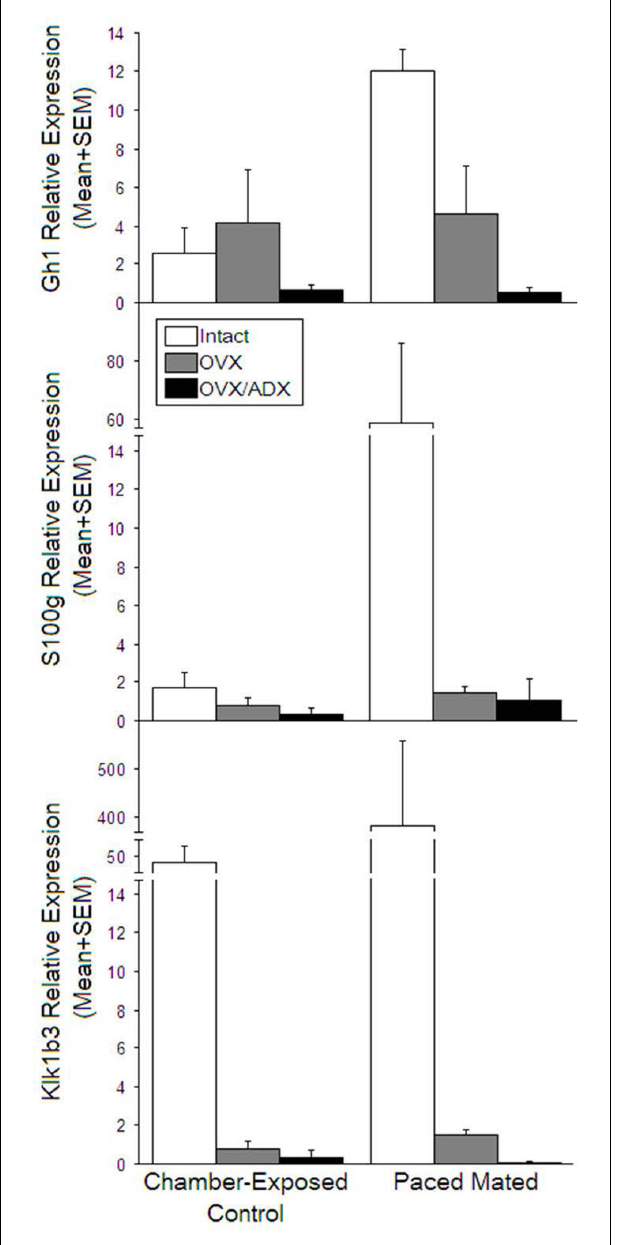
FIGURE 2 | Relative expression among among naturally receptive rats (open bars), ovariectomized estradiol primed (gray bars) and ovariectomized and adrenalectomized estradiol primed (black) that were just exposed to the mating chamber left side of graph or were actually mated (right side of graph). Top panel: GH1 was elevated most among naturally mated rats, and was increased similarly among estradiol primed rats whether mated or not. Middle panel S100 expression was increased most among naturally mated rats. Bottom panel kallikrekin 1-related peptidase b3 (Klk1b3, a.k.a.Ngfg) was increased in naturally receptive rats irrespective of mating.